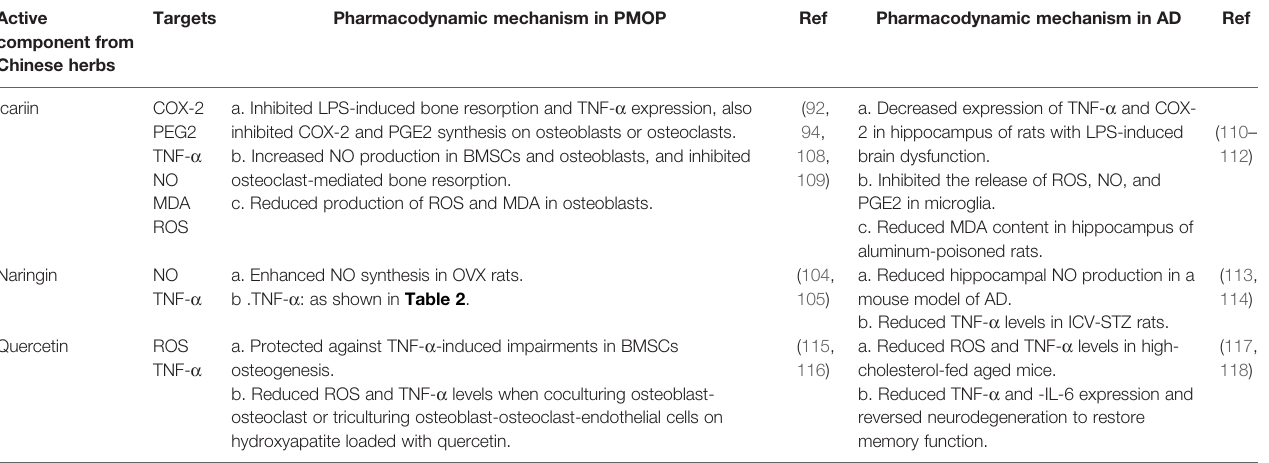
TABLE 3 | Summary of potential active components from Chinese herbs to be applied in PMOP and RA. Active component from Chinese